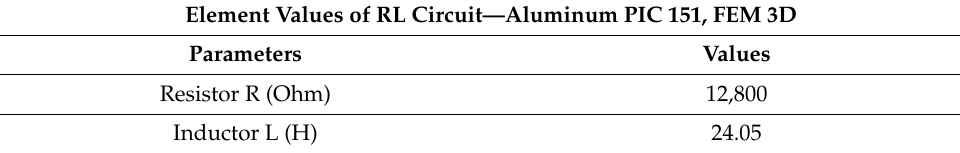
Table 3. Optimal shunt element values based on a 2D FEM model. Table 4. Optimal shunt element values based on a 3D FEM model.